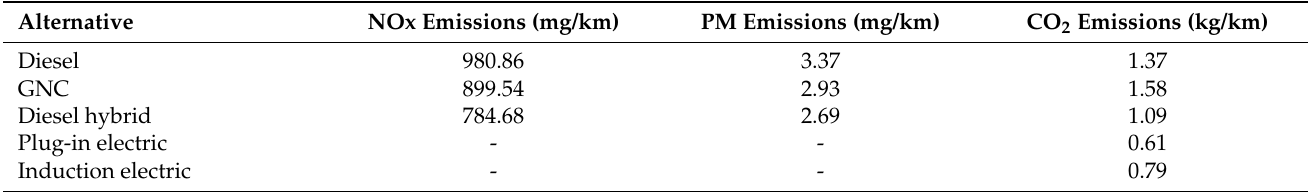
Table 10. Average emissions of pollutants by type of fuel.